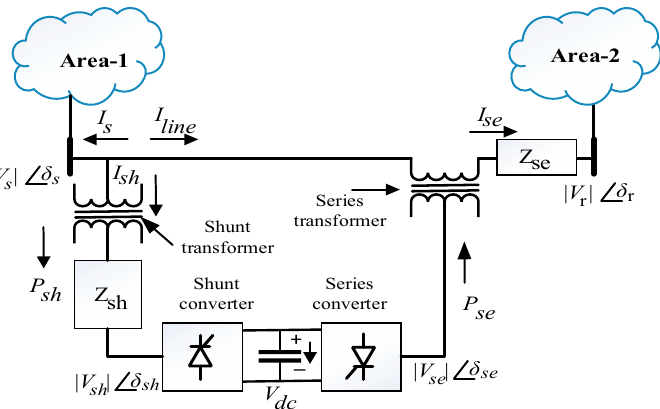
Figure 5. UPFC connection in the two-agent deregulated power system.